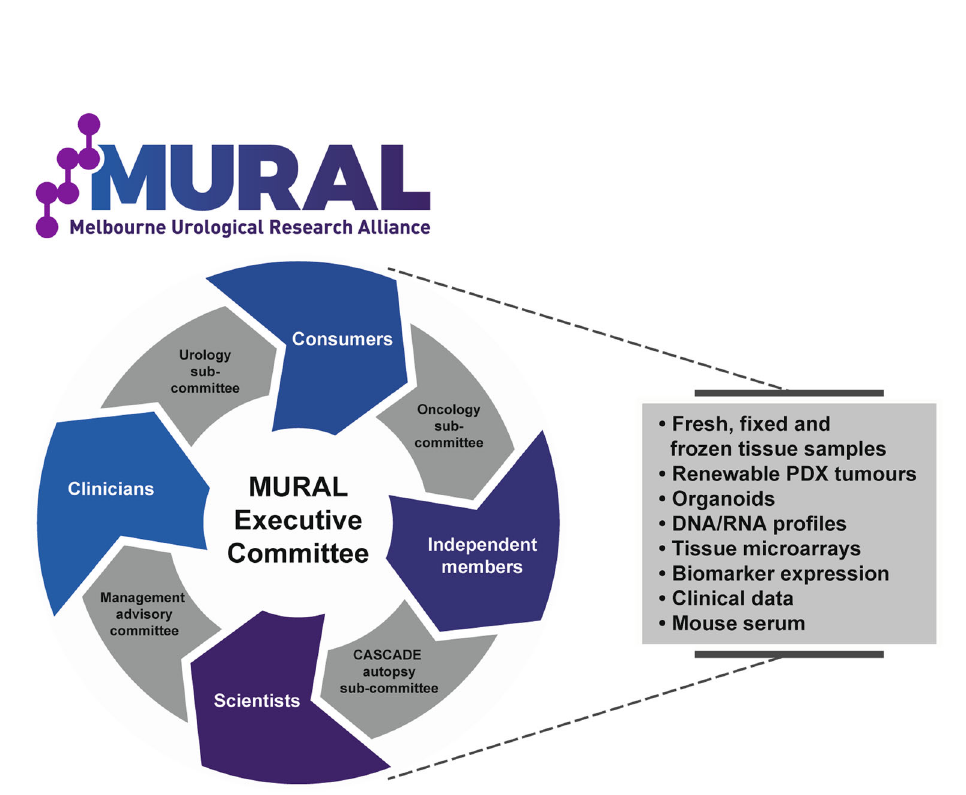
Fig. 6 Sharing and distribution of the MURAL PDX collection. MURAL is a PDX biospecimen resource that is available for collaborative, investigator-led research. This schematic shows the organisation of MURAL, with four working sub-committees that are overseen by an executive committee. Resources available from MURAL include PDX tumors, tissue samples, tissue microarrays (TMAs), organoids, DNA/RNA pro fi les, and clinical